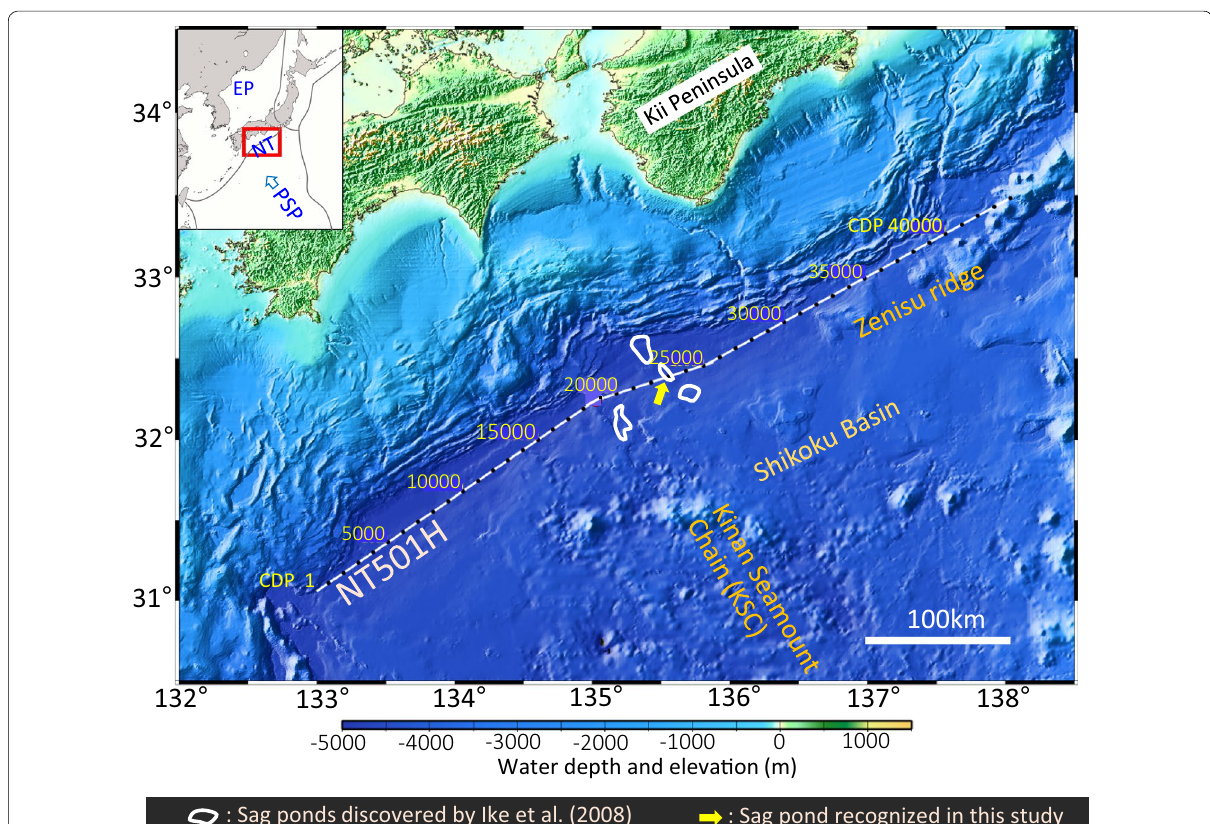
Fig. 1 Study area and seismic line. High‑resolution seismic reflection data have been collected using GI guns along the seismic line NT501H follow‑ ing the axis of the Nankai